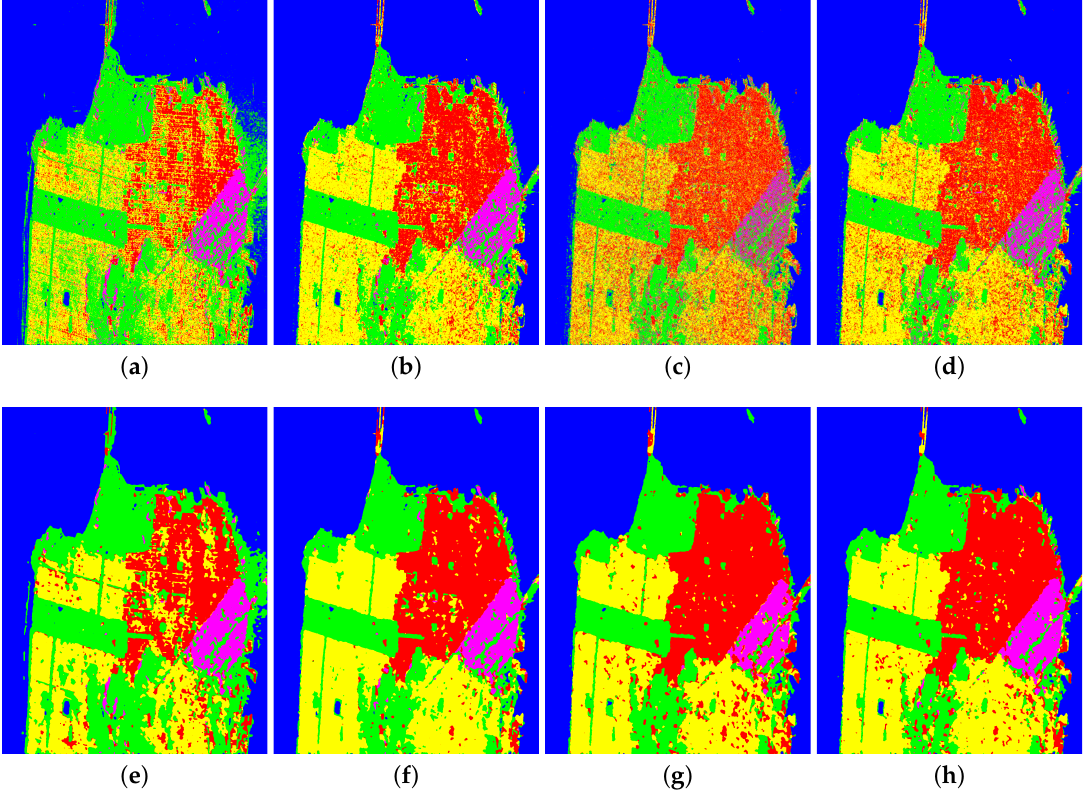
Figure 7. Prediction result of San Francisco bay image generated by different methods, including: ( a ) Wishart classifier; ( b ) SVM; ( c ) classification network based on AE; ( d ) classification network based on the proposed MAE; ( e ) Wishart classifier with PP step; ( f ) SVM with PP step; ( g ) AE with PP step; and ( h ) MAE with PP